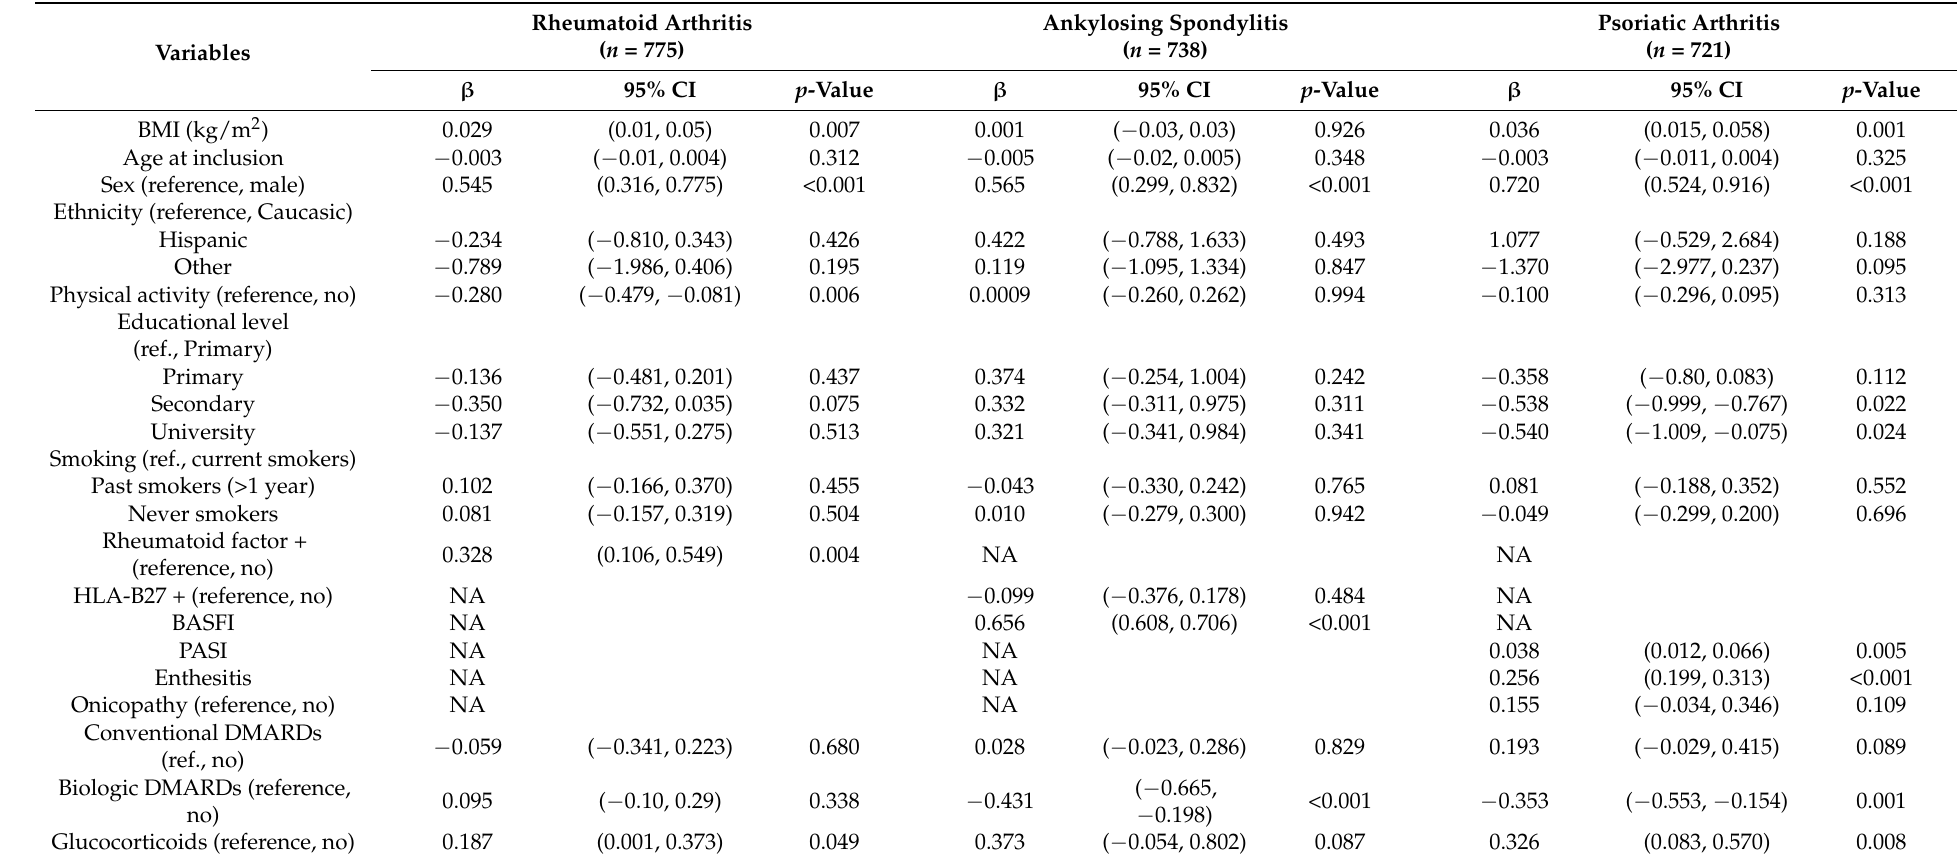
BASFI: Bath Ankylosing Spondylitis (AS) Functional Index; BMI: body mass index; CARMA: CARdiovascular in RheuMAtology; CIRD: chronic inflammatory rheumatic diseases; DMARD(s): disease-modifying anti-rheumatic drugs; HLA-B27: Human leucocyte antigen B27; PASI: Psoriasis Area Severity Index. Data are expressed as β -coefficients (95% CI) and p -values. NA: not